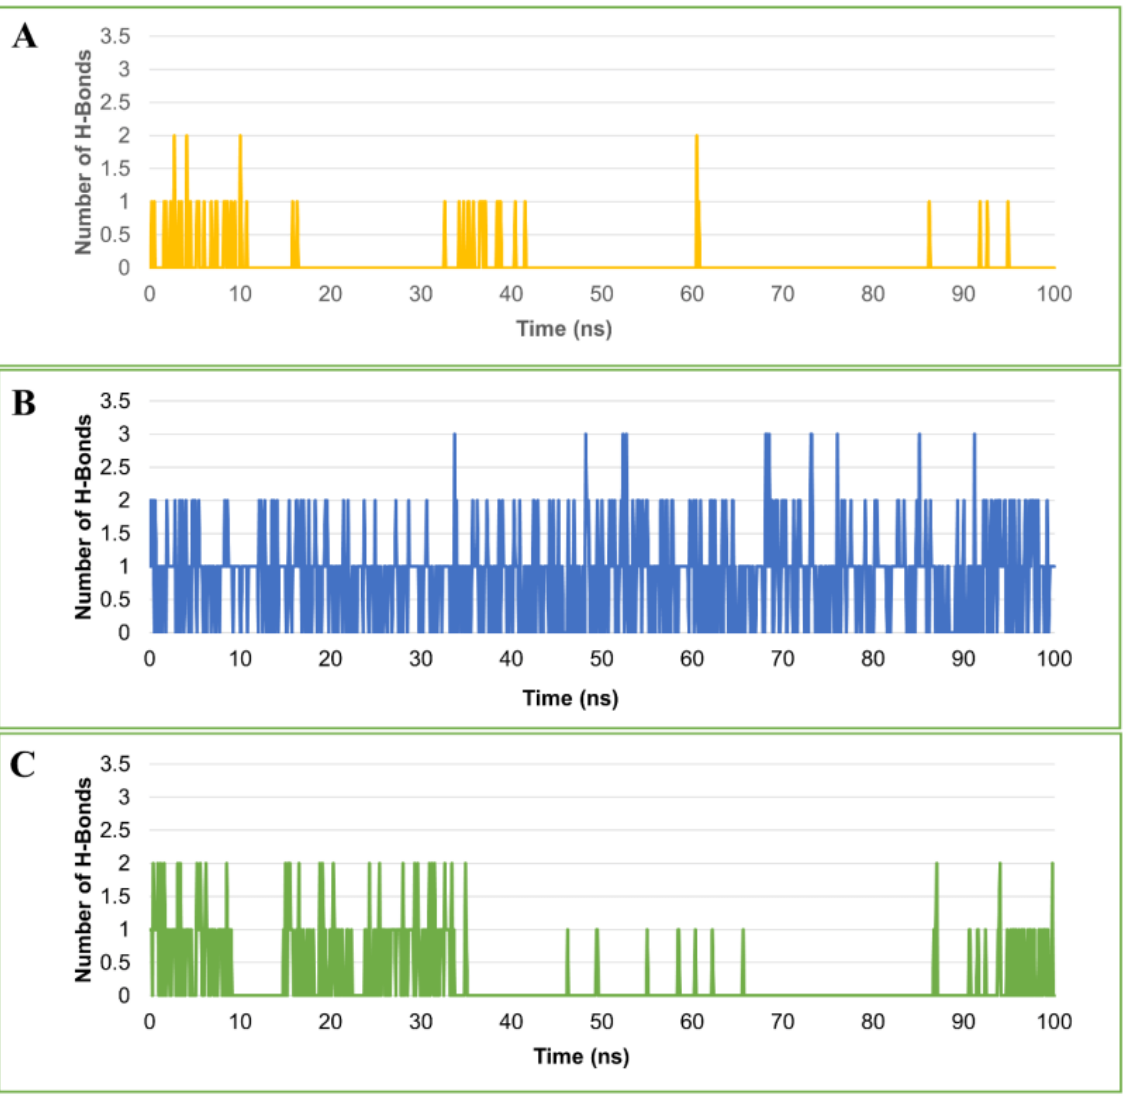
Figure 7. Plot of number of hydrogen bonds observed in the complex of carbonic anhydrase and ZINC12336992 ( A ), ZINC24751284 ( B ), and ZINC58324738 ( C ) during the 100-ns molecular dynam- ics simulation.